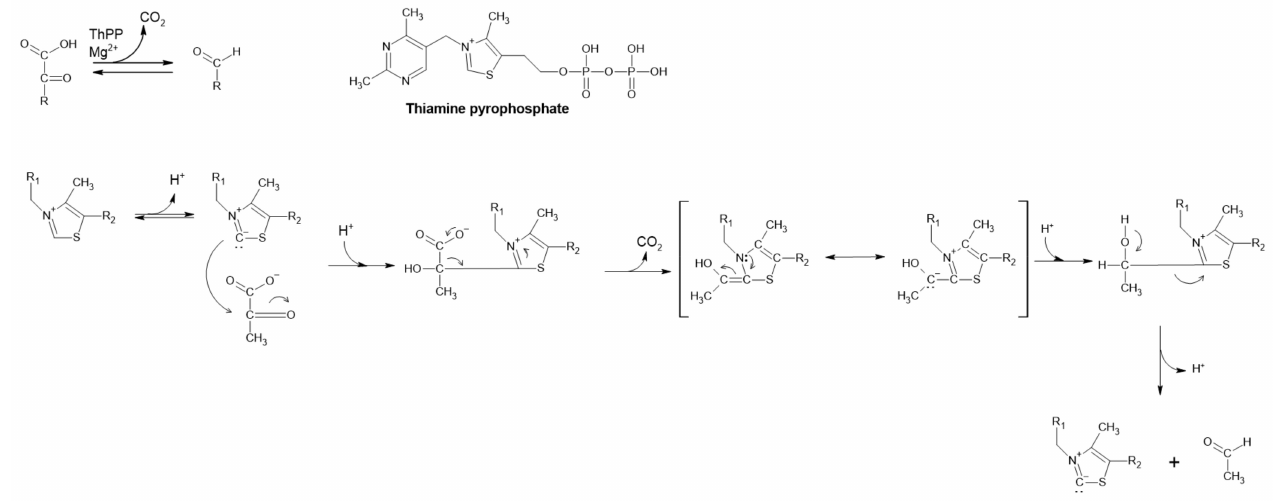
Figure 6. Reaction mechanism of PDC and its cofactor,